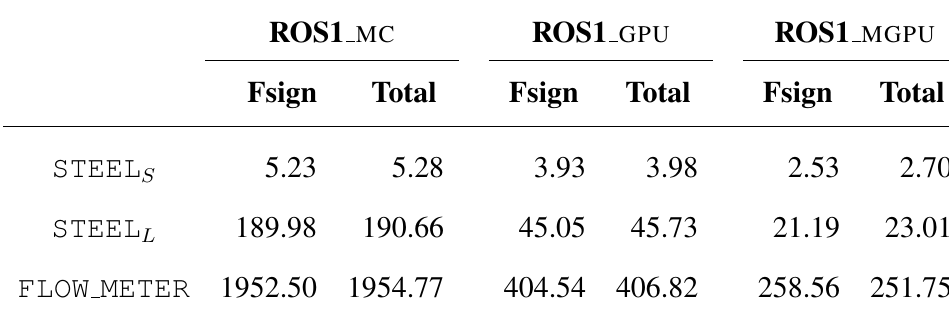
Table 4. Execution time (in seconds) for the solution of differential Riccati